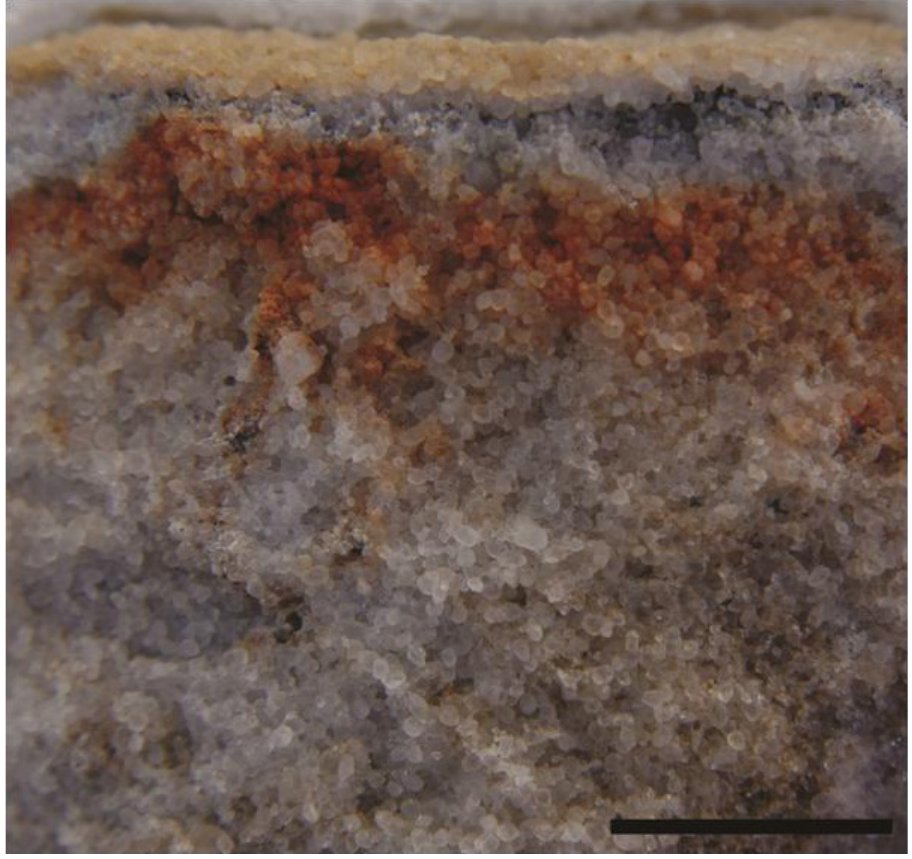
Figure 3. Fractured sandstone showing the presence of microorganisms just below the surface. The leaching of iron from the surrounding sandstone improves photosynthetic access to sunlight. (Scale 5